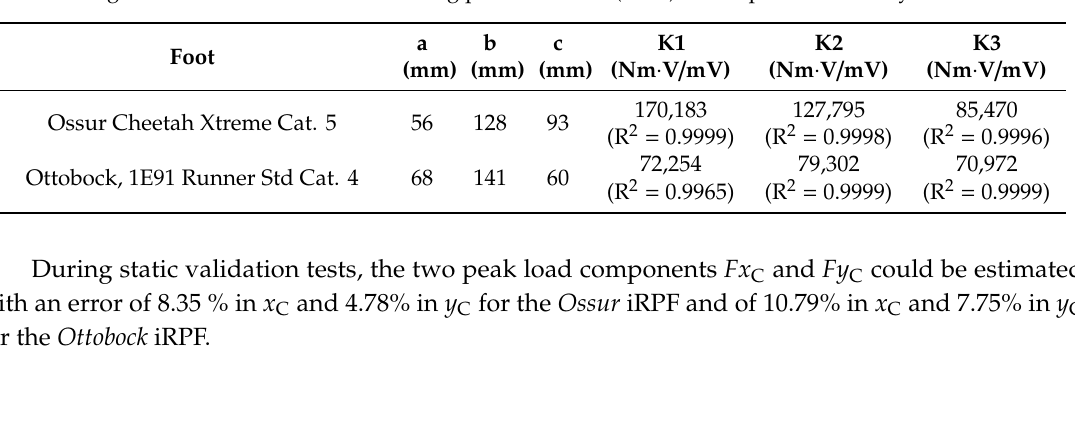
Table 1. Bridge geometrical parameters (ref. Figure 4) and bridge calibration constants (ref. Equation (2)) resulting for the two instrumented running prosthetic foot (iRPF) developed in the study.